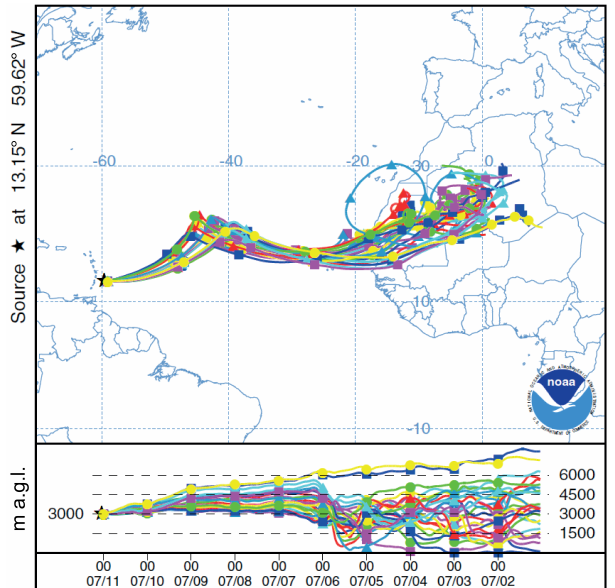
Figure 3. Ensemble of 10-day backward trajectories (Stein et al., 2015; HYSPLIT, 2016) for 11 July 2013, 01:00UTC, arriving at 3000m over Barbados.